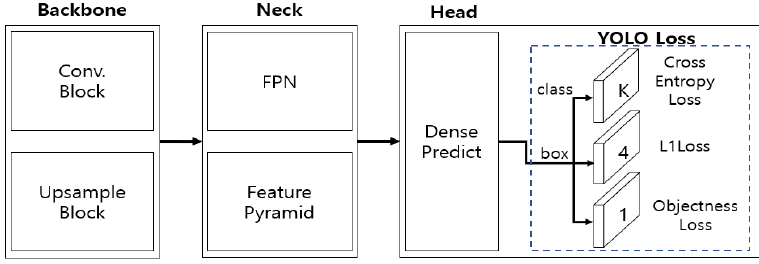
Figure 7. The architecture of the Yolov3-416 model and YOLO Loss [20].